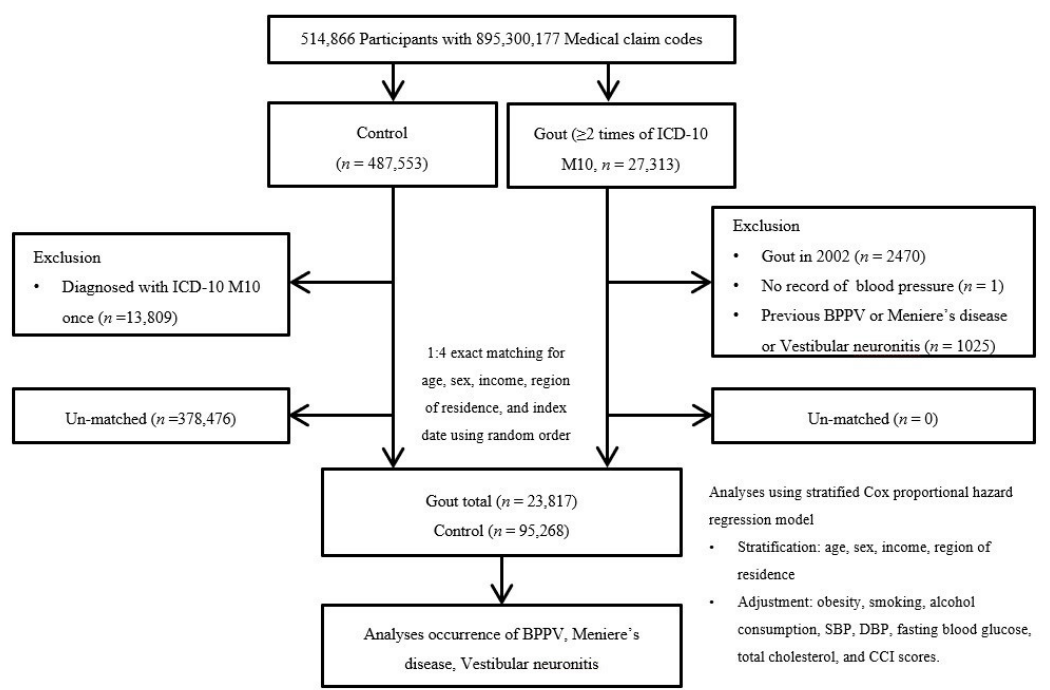
Figure 1. A schematic diagram of the participant selection process. From 514,866 total participants, 23,817 participants with gout were matched with 95,268 control participants according to age, sex, income, and region of residence. Abbreviation: ICD-10 = International classification of disease-10; CCI = Charlson comorbidity index; SBP, Systolic blood pressure; DBP, Diastolic blood pressure.